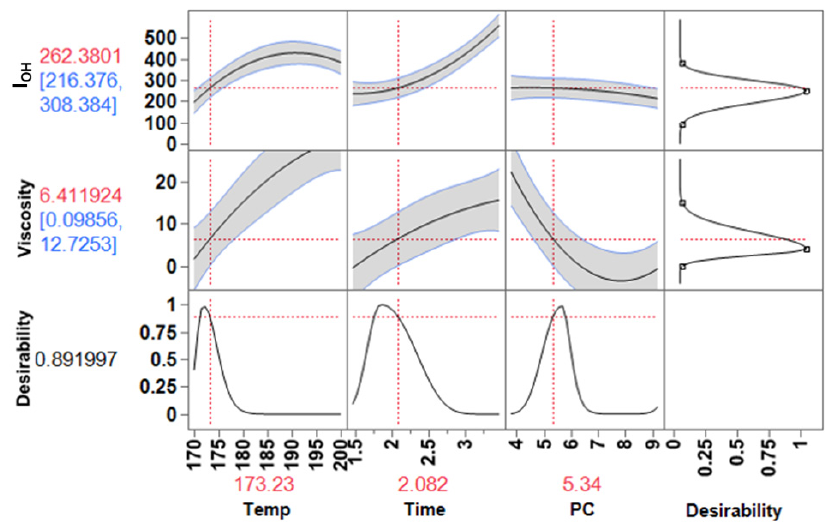
Figure 11. Prediction profiler and desired conditions for required I OH and viscosity of lignin-based polyol to produce polyurethane adhesives.